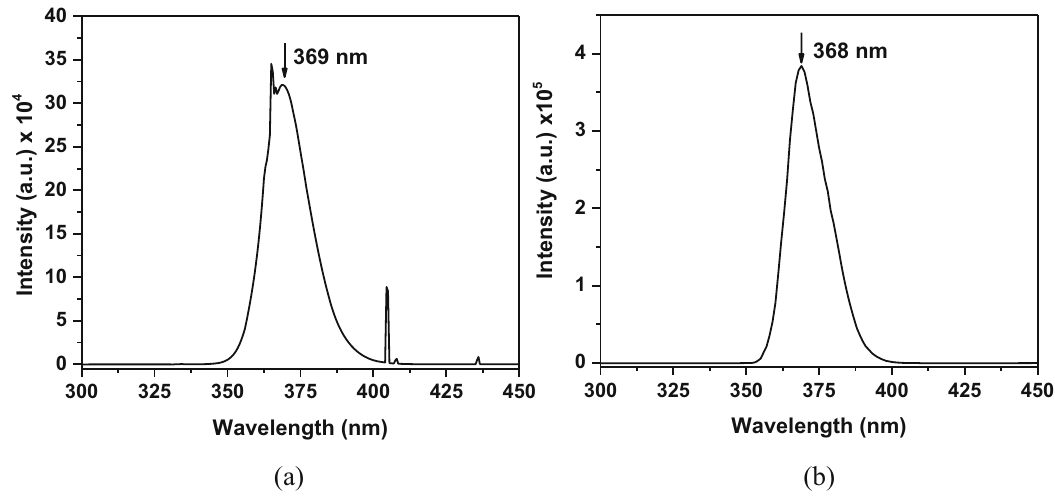
Figure 5: Emission spectra of UV sources used to simulate UV component of sunlight in the experiments with down - conversion materials: ( a ) Insect killer UV black light ( intensity ∼ 8.8 mW/cm 2 ) . ( b ) UV LED fl ashlight ( intensity ∼ 25.6 mW/cm 2 )